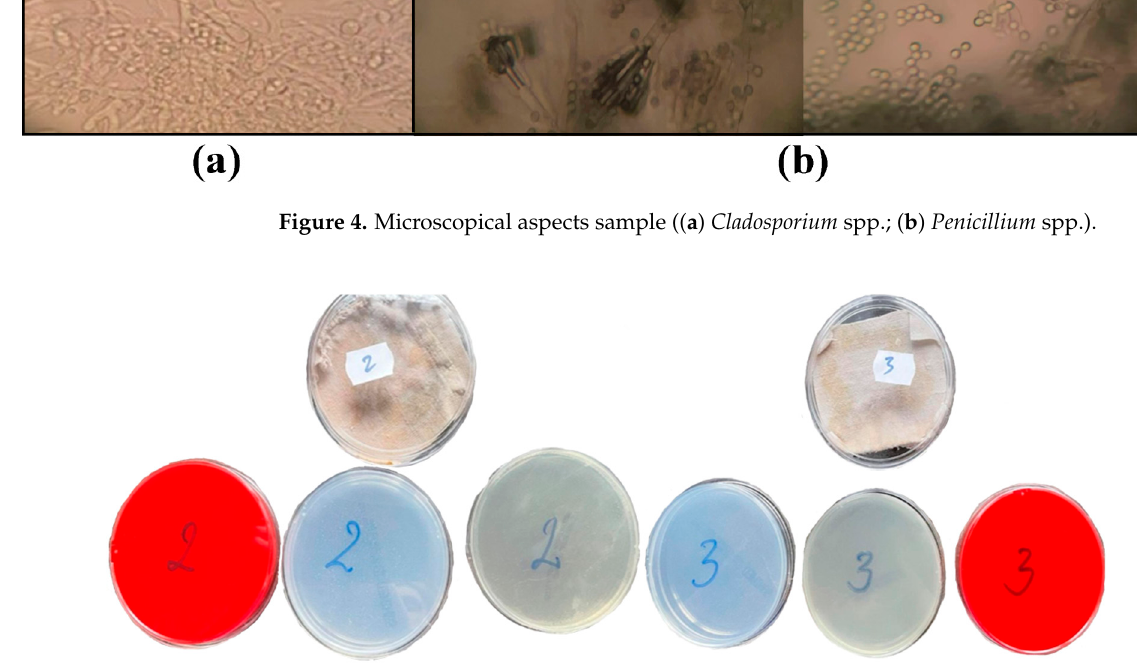
Figure 5. Culture plates after NNPSAg treatment of samples 2 and 3.